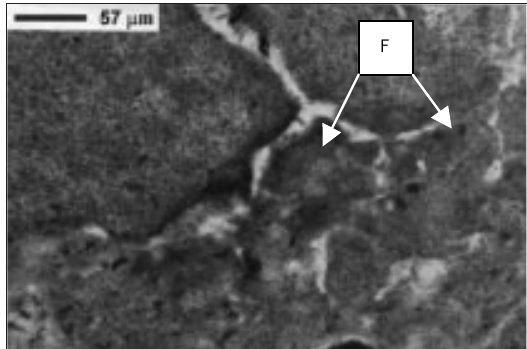
Figura 2. Fotomicrografia em nicóis cruzados de neocutãs de difusão (ferrãs - F), no horizonte BC1 do CeTb (P5).